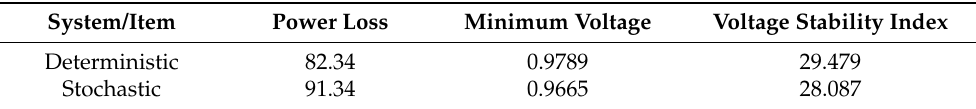
Table 4. Comparison of the results of PVs allocation in deterministic and stochastic conditions for a 33-bus distribution network.